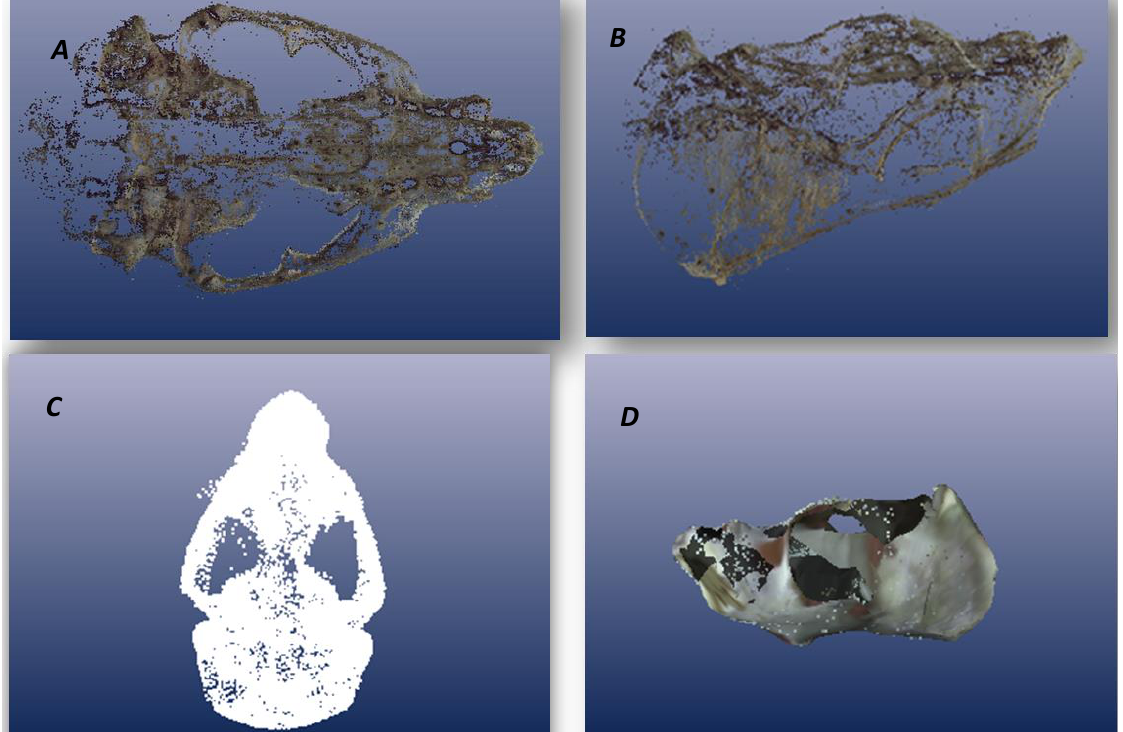
Figure 3. Set of 3D modelling at various stages of processing using Photomodeler Scanner®, A, Initial stage of natural skull features extraction, B, Three-dimensional modelling of the natural features, C, 3D skull in the default and dots surface layer, D, partially complete 3D model used for